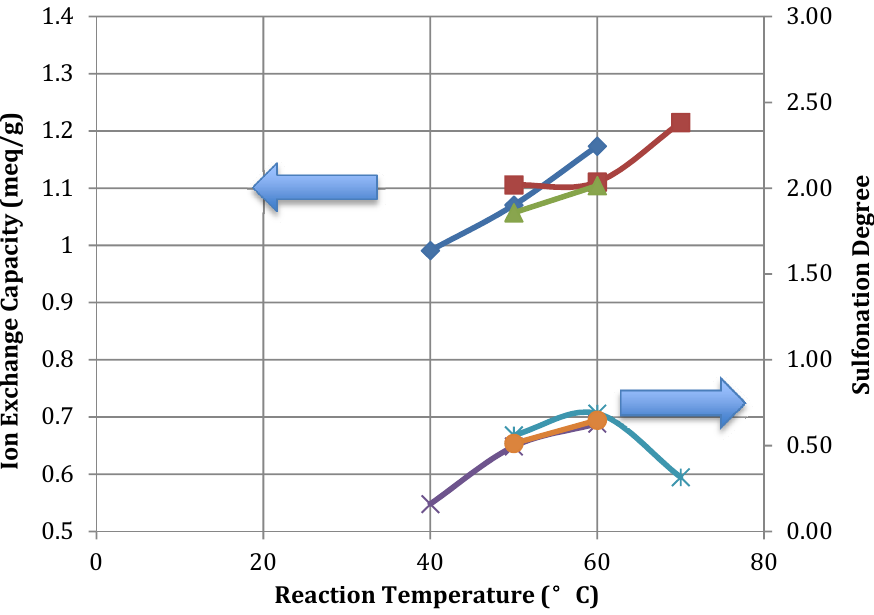
Figure 2. SPEEK IEC and degree of sulfonation (DS) for various reaction temperatures (×, 6 h SD; ○ , 3 h SD; *, 2 h SD; diamond, 6 h IEC; ∆ , 3 h IEC; □ , 2 h